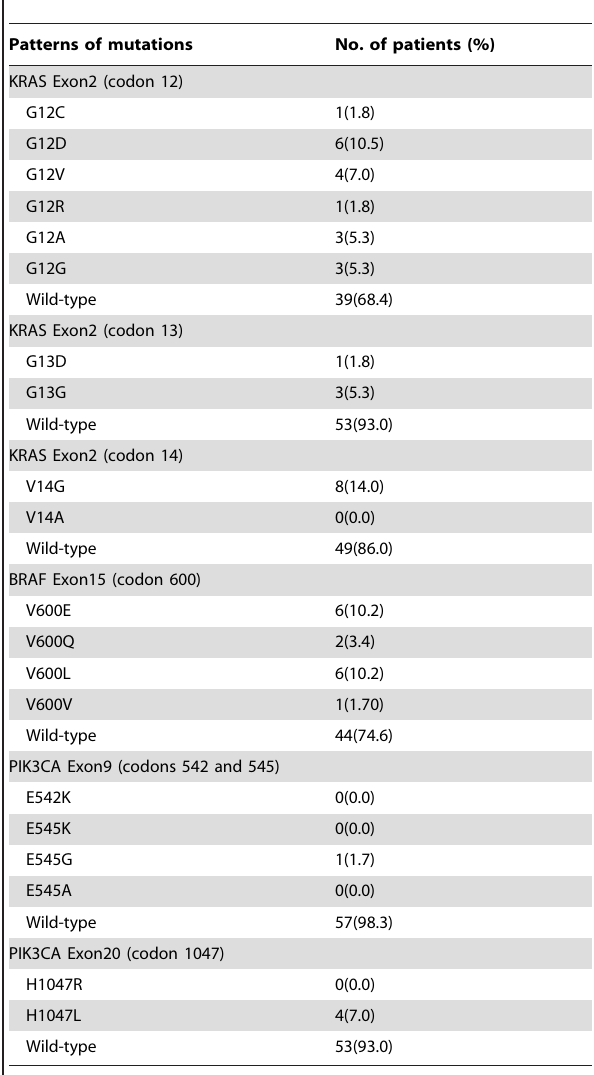
Table 2. The Primers used in PCR amplification and sequencing.